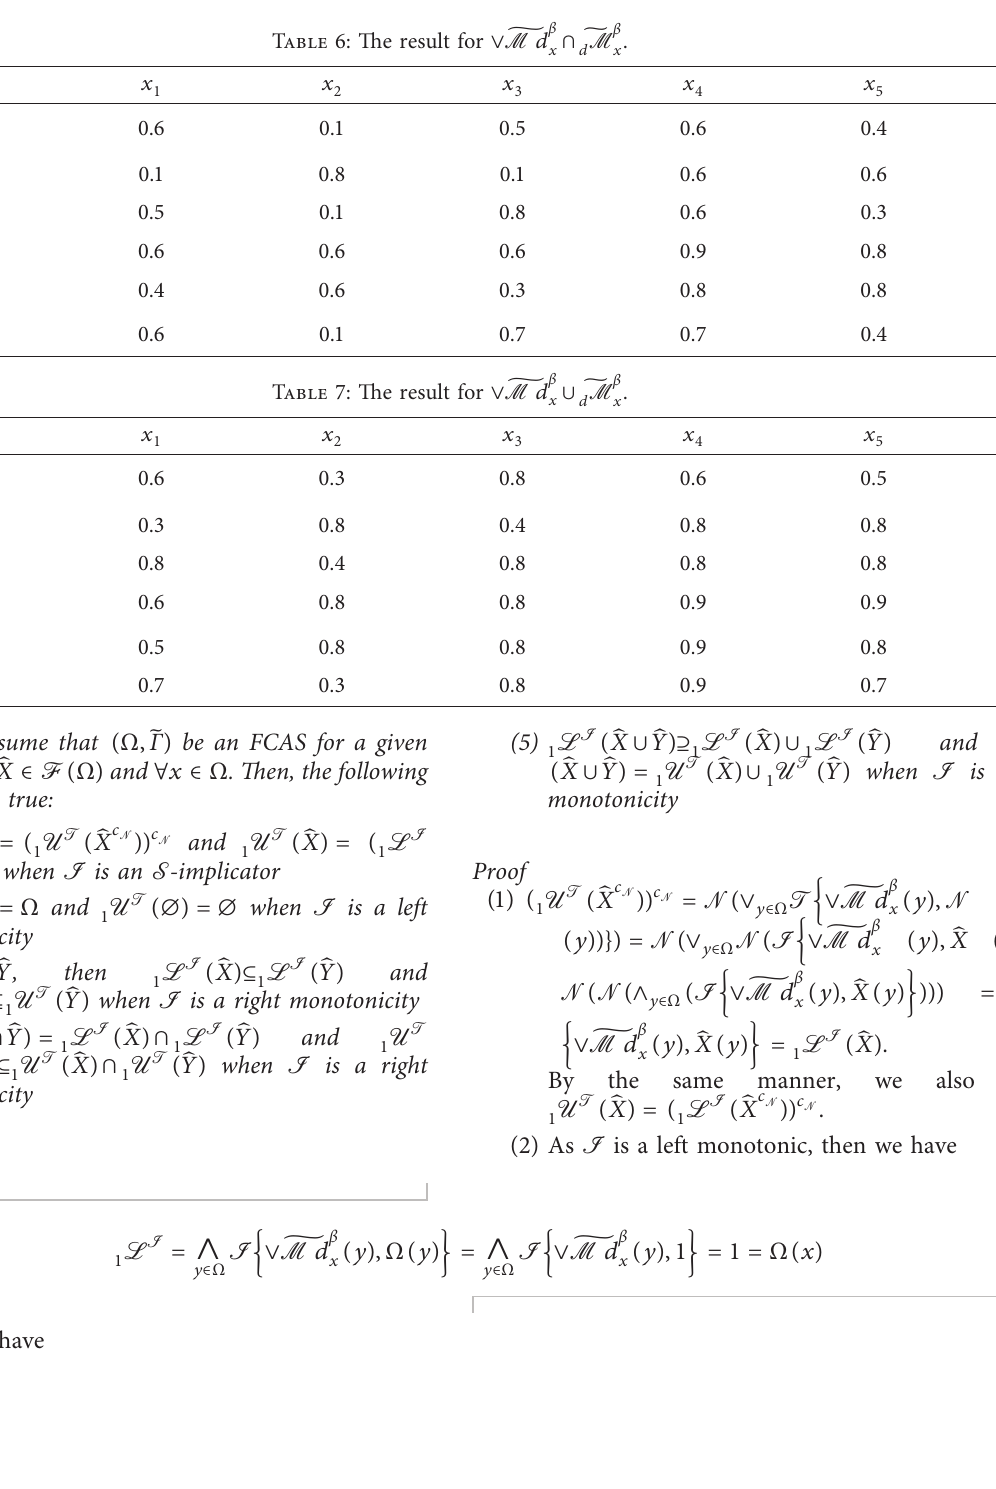
Table 6: The result for ∨ 􏽧 M d β